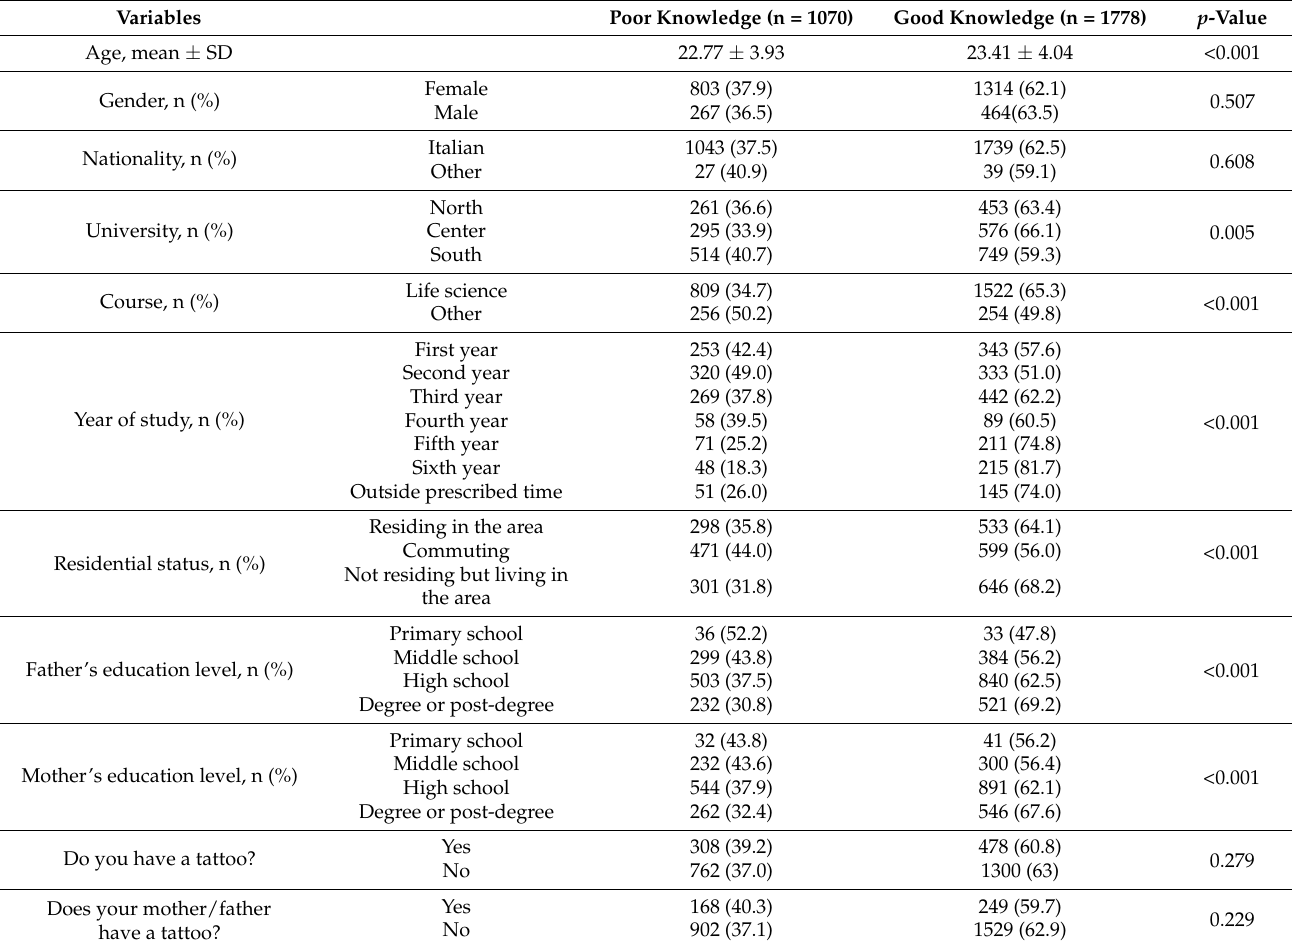
Table 2. Univariate analysis of knowledge about tattooing health